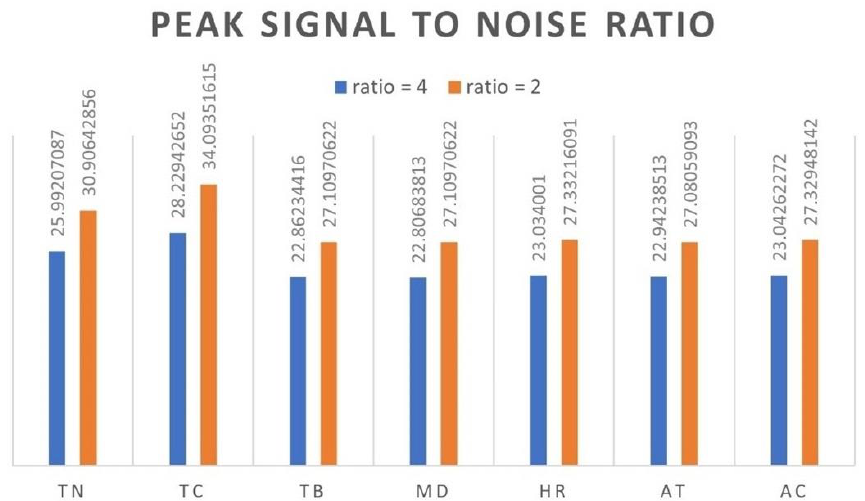
Figure 12. Average PSNR: traditional nearest neighbor (TN), traditional bicubic (TC), traditional 326